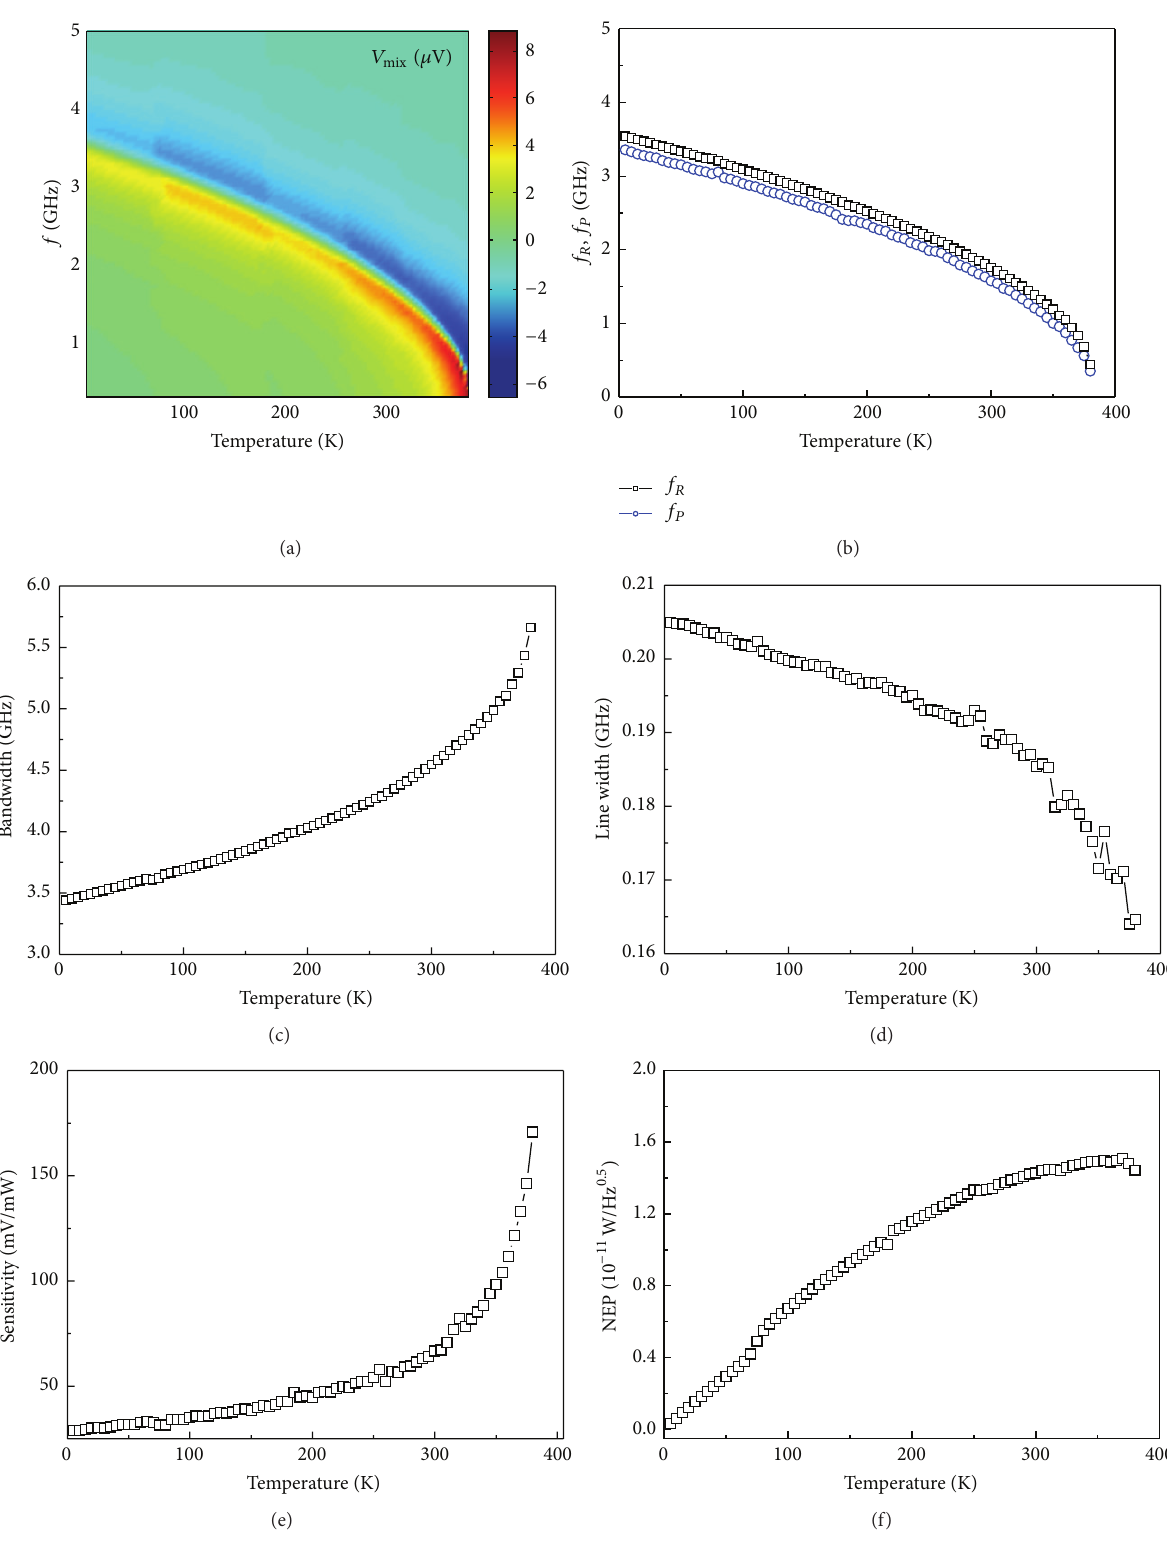
Figure 5: (a) The contour plots of 𝑉 mix - 𝑓 spectra, the temperature dependence of (b) 𝑓 𝑅 and 𝑓 𝑃 , (c) bandwidth, (d) line-width, (e) sensitivity, and (f) NEP when 𝛽 M = 45 ∘ , 𝜇 0 𝐻 = − 60mT, 𝜃 𝐻 = 90 ∘ , and 𝛿 𝐻 = 40 ∘